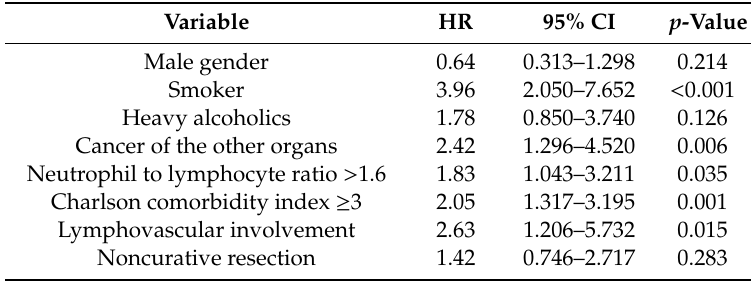
Table 5. Multivariate analysis of factors associated with overall